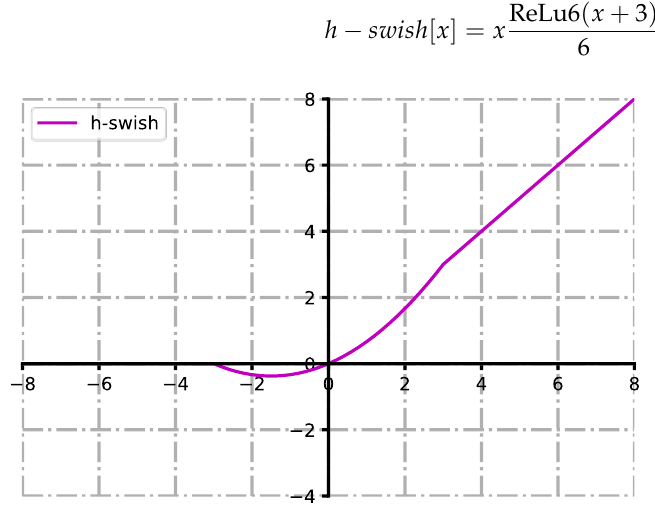
Figure 6. h-swish activation function.